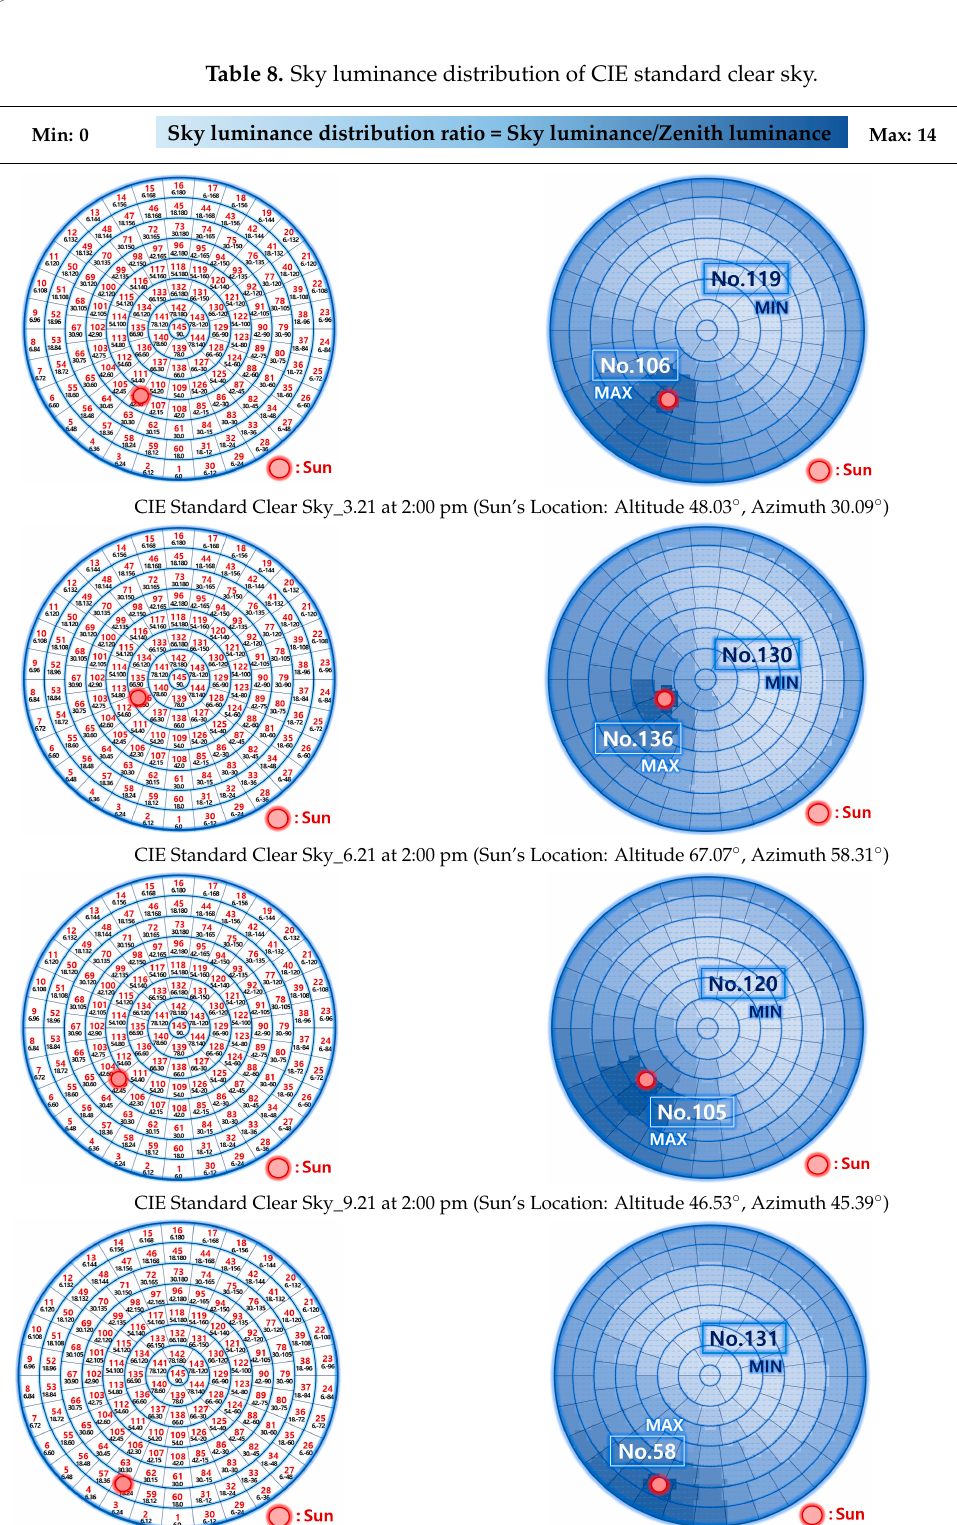
Table 8. Sky luminance distribution of CIE standard clear sky.